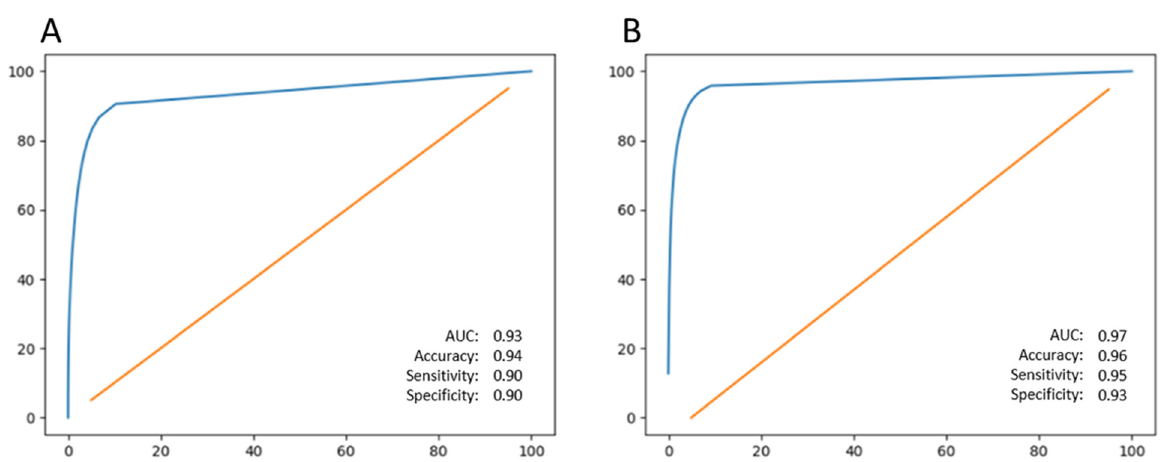
Figure 7. ( A ) Receiver operator curve for automatic pixel-wise GA area segmentation for B-scan model; ( B ) Receiver operator curve for automatic pixel-wise GA area segmentation for en face model. The line in orange denotes random chance and the line in blue denotes the model output. GA: Geographic